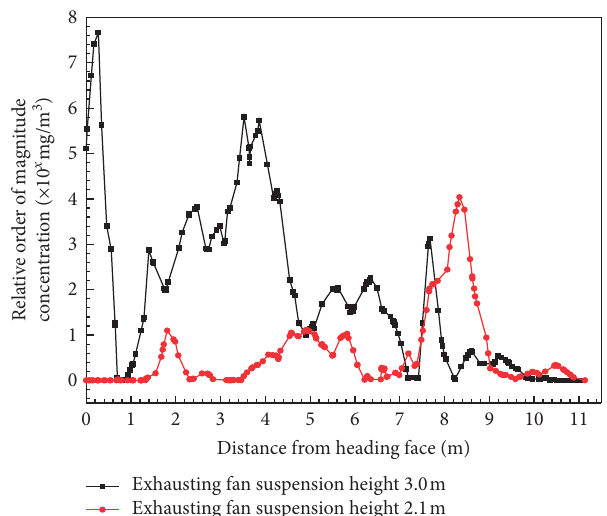
Figure 11: Comparison of the dust concentration.